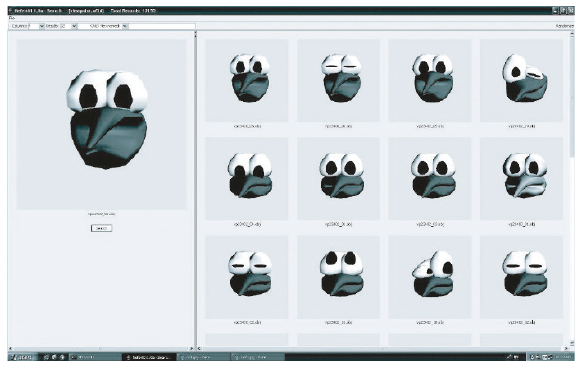
Figure 2: Retrieval of an animated 3D character: the reference ob- ject appears on the left side while the outcome of the query appears on the right side. Each result is characterised by a di ff erent facial expression, that is, a GCT. In the present query, all the facial ex- pressions of the character were retrieved without any inlayer from a database containing 12 . 150 objects.